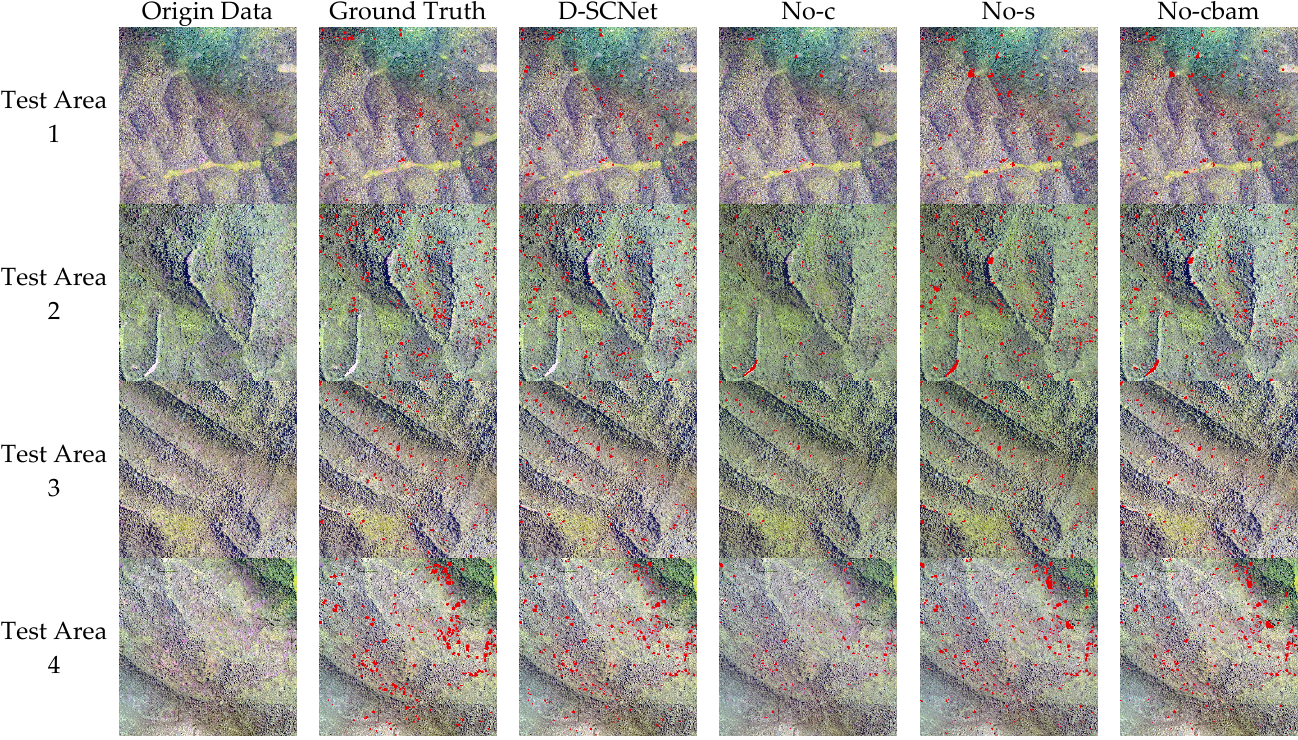
Figure 14. Comparative results of ablation experiments. Table 6. Accuracy evaluation of ablation experiments.